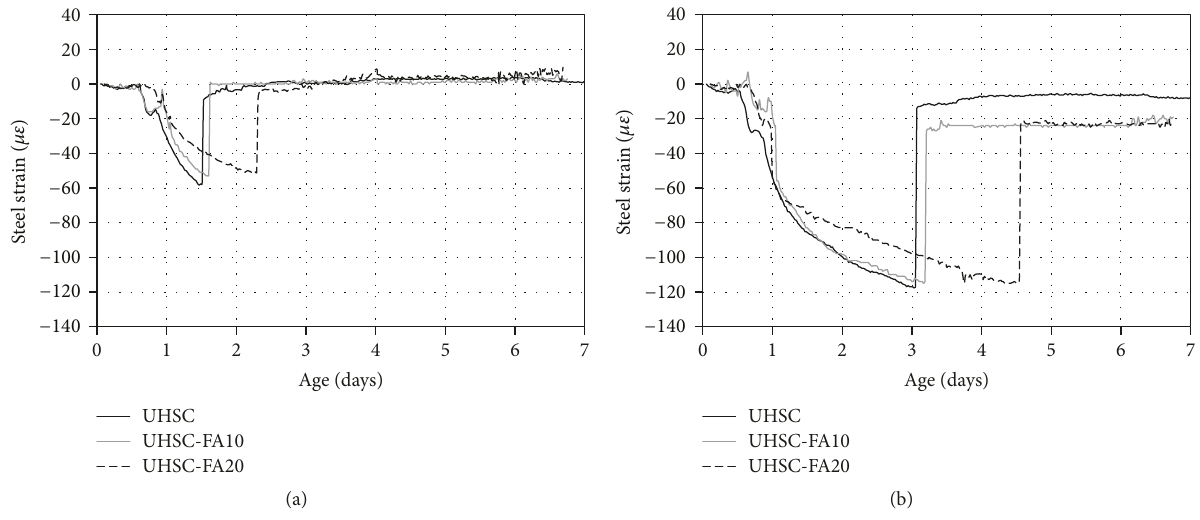
Figure 10: Average strain in the steel ring of UHSC with fly ash: (a) 35 mm concrete ring; (b) 76 mm concrete ring.